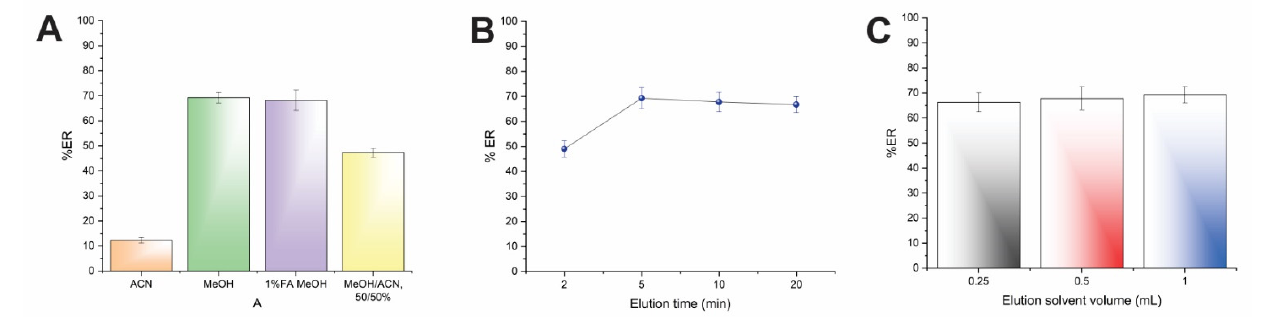
Figure 4. Effect of the ( A ) elution solvent type, ( B ) elution time, and ( C ) elution solvent volume on the%ER of AMB.